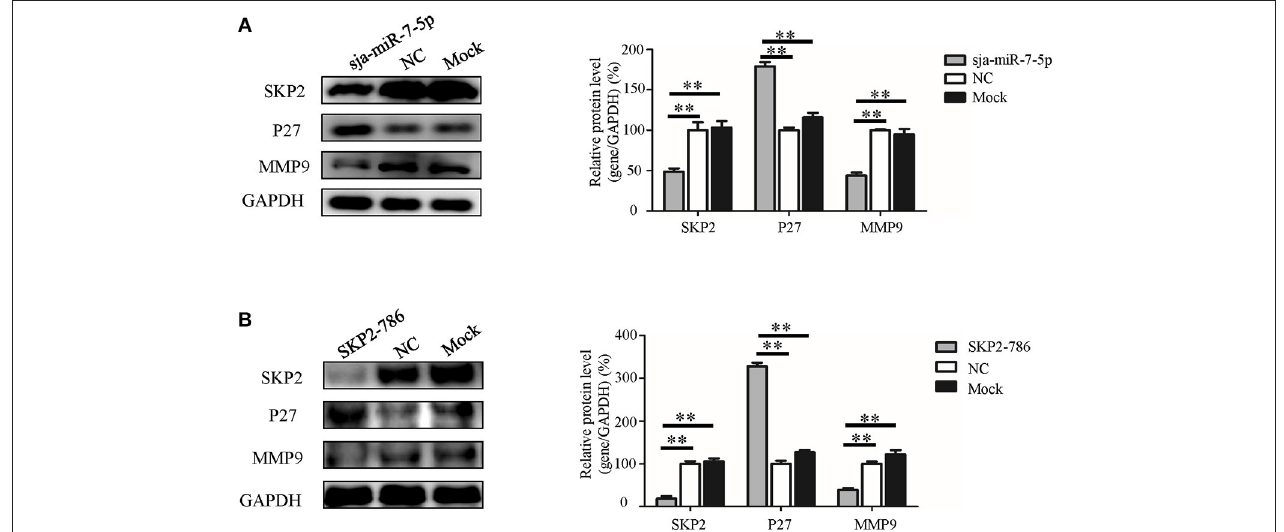
FIGURE 7 | The molecular mechanism whereby sja-miR-7-5p exerts its antitumor activity in hepatoma cells. (A,B) In Hepa1-6 cells, the protein levels of SKP2, P27, and MMP9 were measured by Western blotting after transfection with sja-miR-7-5p mimics (A) or Skp2 siRNA (B) and their corresponding negative controls, with glyceraldehyde-3-phosphate (GAPDH) as the internal control. Data are presented as the mean ± SD, n = 3, ** p <